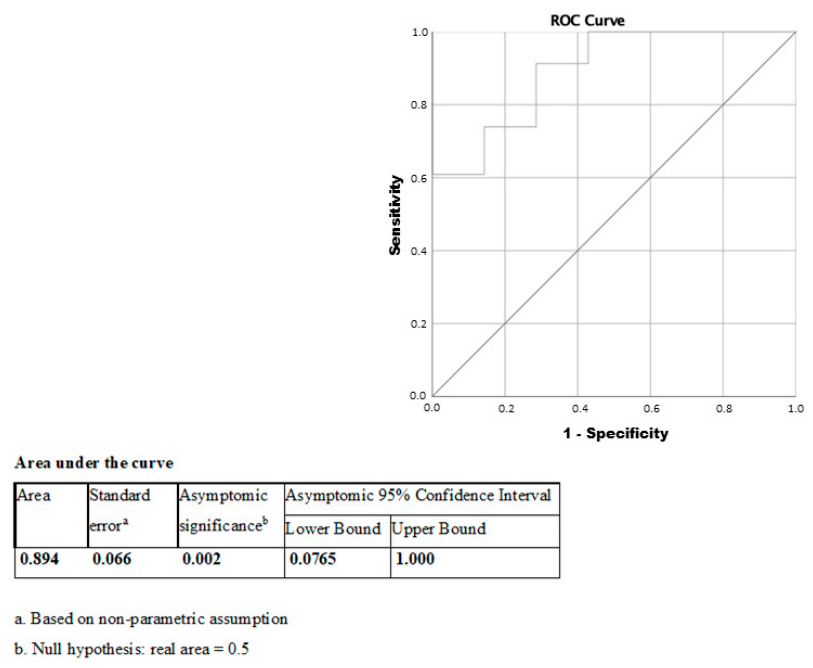
Figure 4. VAT BVR-A mRNA expression receiver operating curve (ROC) for Figure 4. VAT BVR ‐ A mRNA expression receiver operating curve (ROC) for NAFLD.